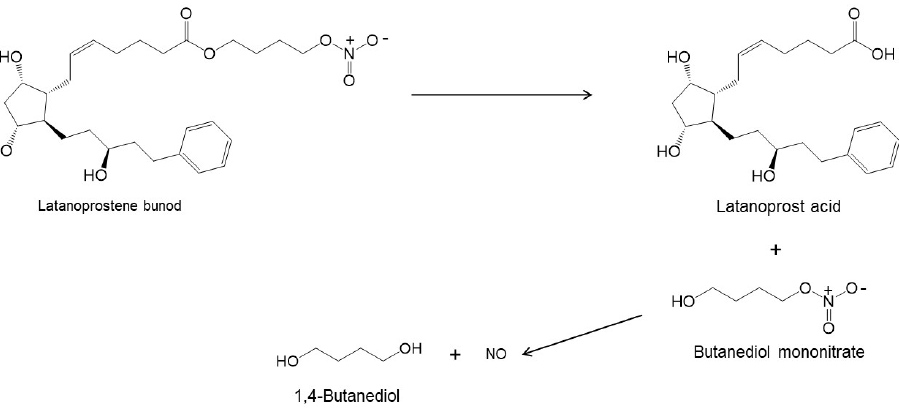
Figure 3. Hydrolysis of latanoprostene bunod [11,34] .